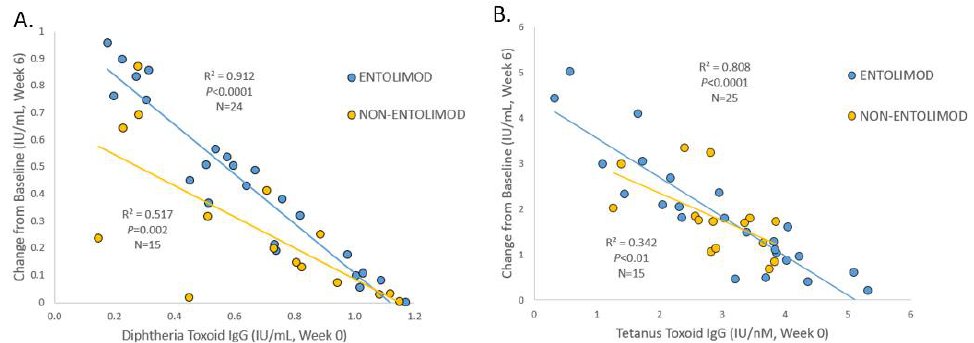
Figure 1. ( A ): Correlation of change in anti-diphtheria antibodies with baseline titers at week 0 for Entolimod and non-Entolimod treatment groups. ( B ): Correlation of change in anti-tetanus antibodies with baseline titers at week 0 for Entolimod and non-Entolimod treatment groups. The mean change in anti-TT AB titers from the baseline means of 3.0 IU/mL for Ent and 2.9 IU/mL for non-Ent was not significantly different (1.81 vs. 1.82 IU/mL). The corre-